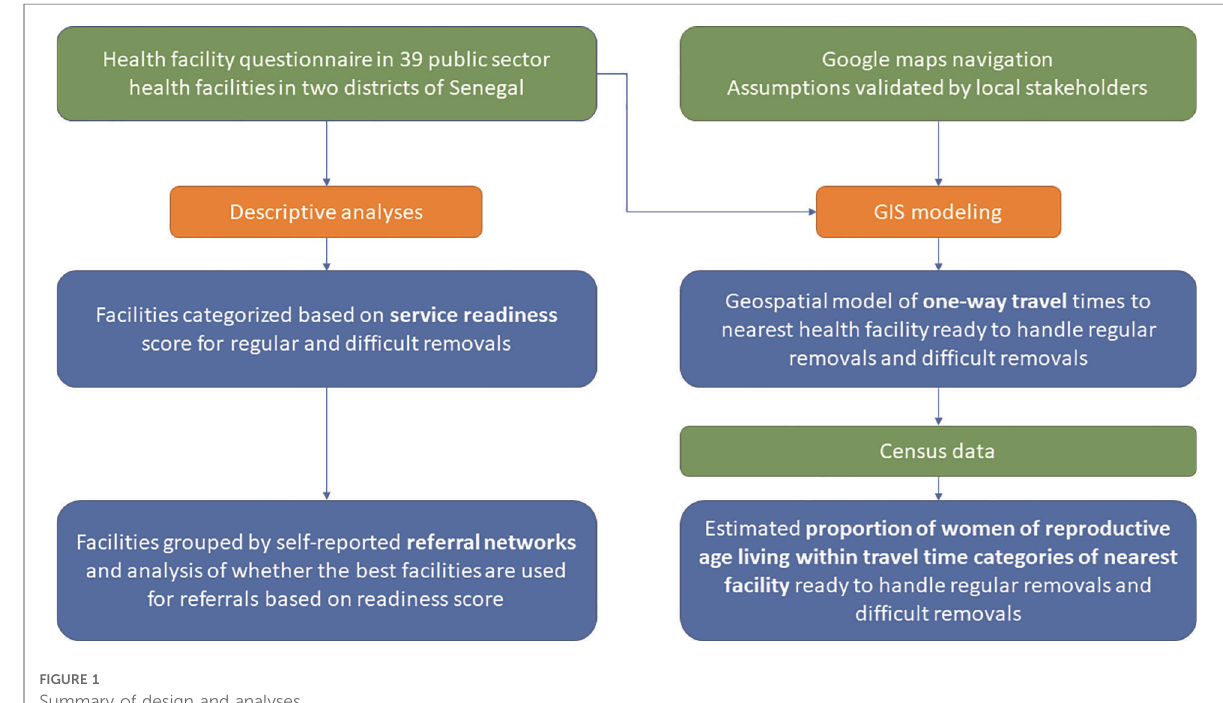
FIGURE 1 Summary of design and